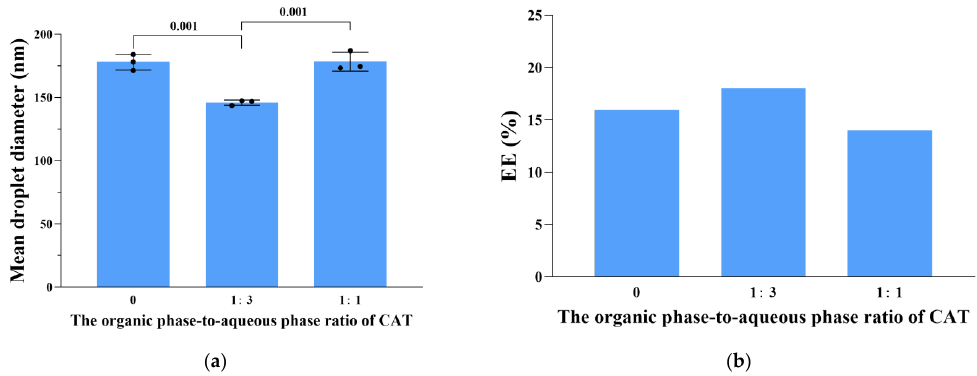
Figure 3. The effect of CAT distribution on the ( a ) droplet size and ( b ) IR780 EE of emulsions. Values are expressed as mean ± SD (n = 3). Each dot represents an independent experiment. The p values vs. indicated groups are presented.